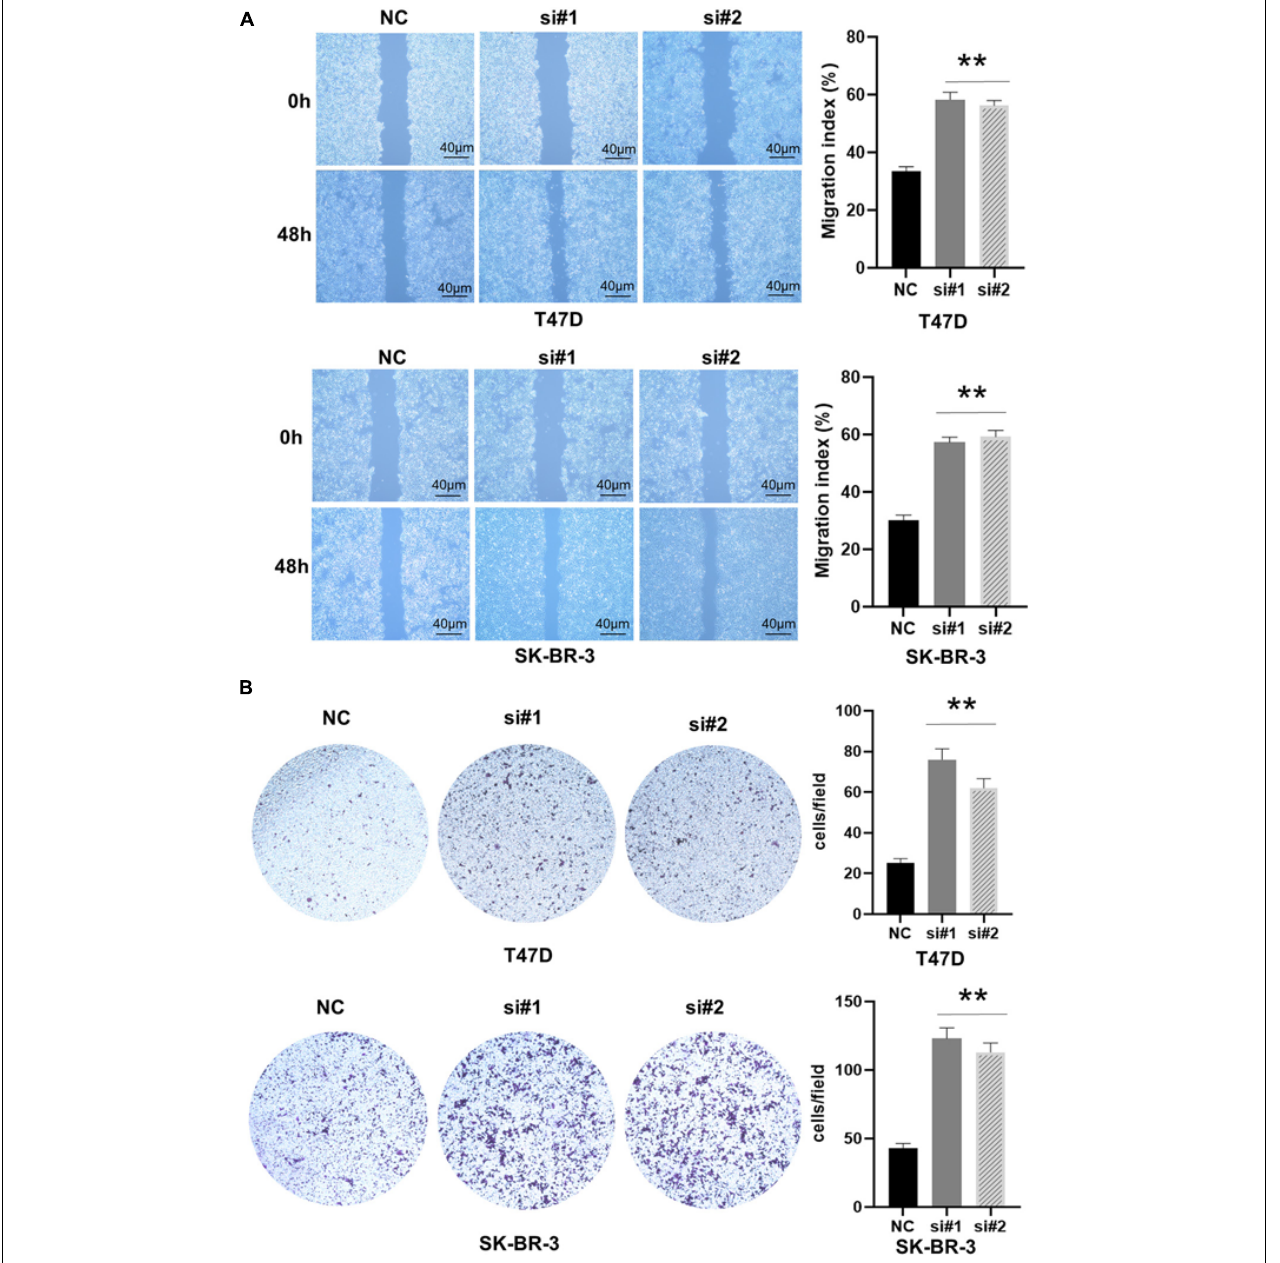
FIGURE 6 | TACC3 knockdown promotes the migration and invasion of the T47D and SK-BR-3 cell line. (A,B) Classic wound healing assay for assessing the migration of siTACC3-treated cells. **compared with control, p < 0.01. All assays were performed in biological triplicate. Data are shown as mean ± S.E.M. **compared with NC, p < 0.01. P -values are calculated by Student’s t -test.